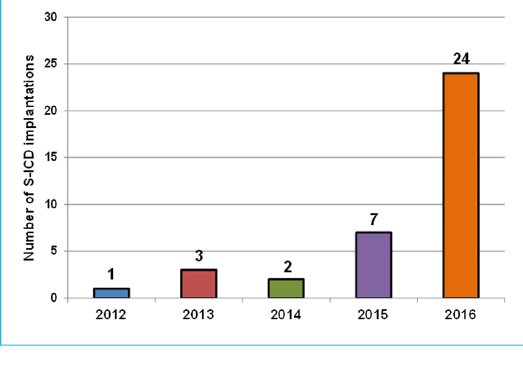
Figure 4: Time to discharge after S-ICD implantation at the Uni- versity Heart Centre Zurich,